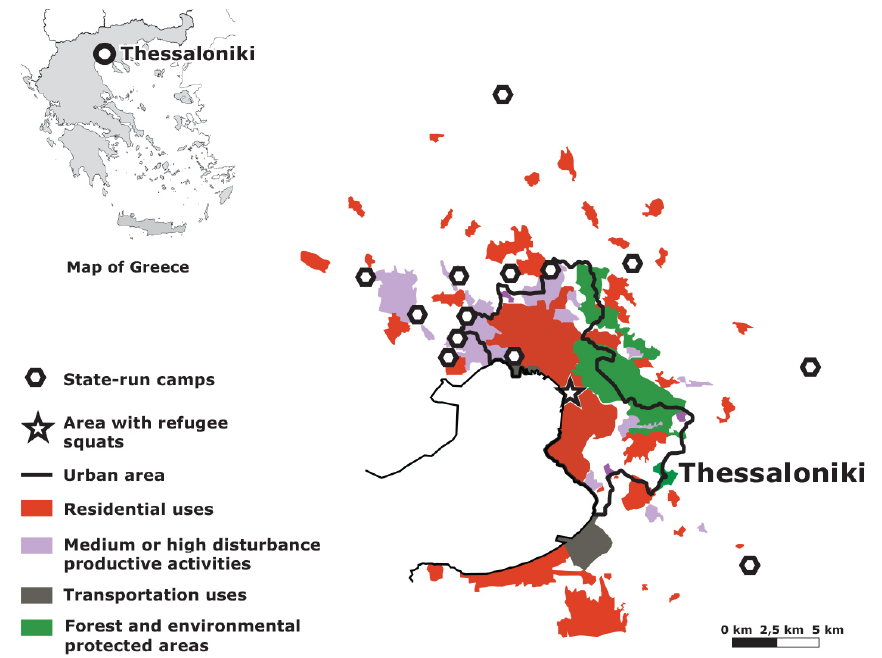
Figure 4. Land use and locations of state-run camps and refugee squats in Thessaloniki. Source: Authors, based on the land uses map of Regulatory Urban Plan of Athens and Thessaloniki Metropolitan Areas